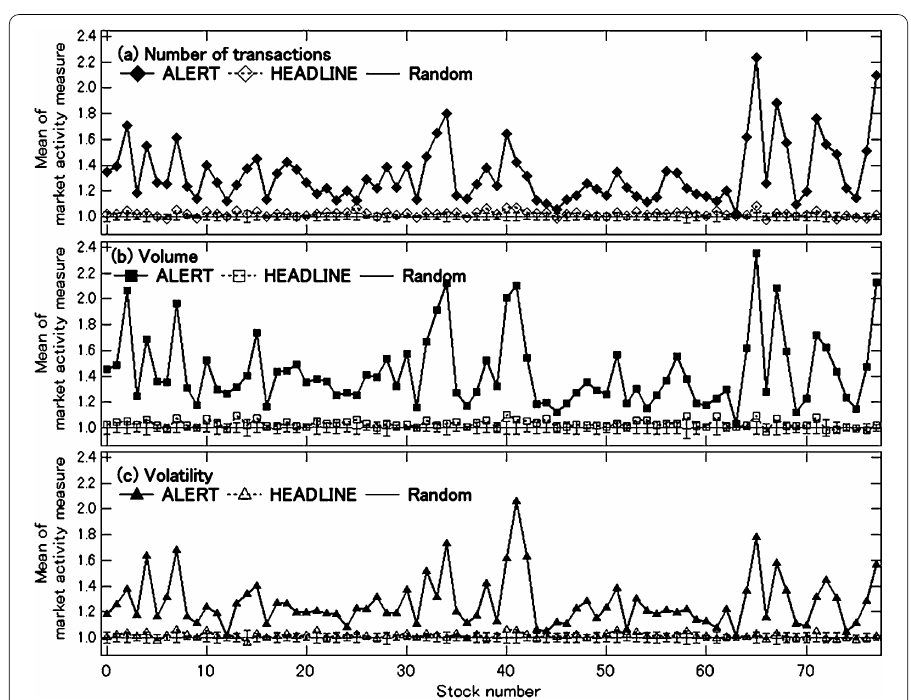
Figure 2 Market activity in 78 stocks in the three minutes after an ALERT or a HEADLINE are displayed. The ticker symbol corresponding to each stock number is provided in Table 1. ( a ), ( b ), and ( c ) show the normalized number of transactions, (cid:3) N (0 ≤ (cid:2) t < 3) (cid:4) , the normalized volume, (cid:3) V (0 ≤ (cid:2) t < 3) (cid:4) , and the normalized volatility, (cid:3) Vol (0 ≤ (cid:2) t < 3) (cid:4) . The error bars shown are for ALERTs and are calculated using randomized data (i.e., the timing of the arrival of news is randomized). The error bars for HEADLINEs are not shown to make the figures easier to read.